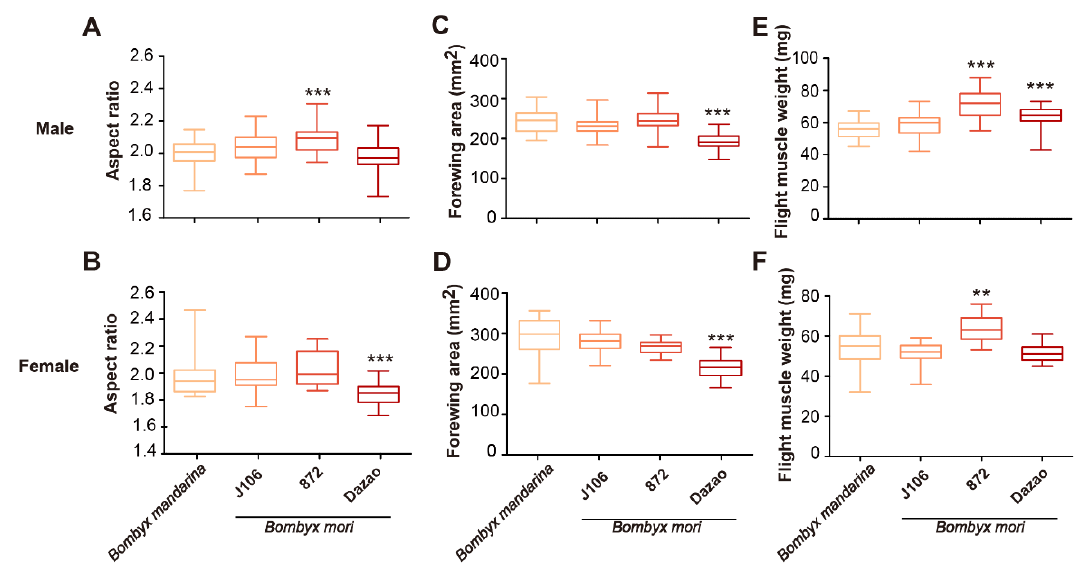
Figure 3. Wing shape (aspect ratio), forewing area (mm 2 ) and flight muscle weight (mg) of silkmoths. The box-plot and box color are described in the legend of Figure 2. The X -axis of the above figures were the same as the bottom. We applied ANOVA tests between B. mandarina and J106, 872, Dazao, respectively. Tukey HSD post hoc tests were shown in Table 3. The significance level is 0.05 (* p < 0.05, ** p < 0.01, *** p < 0.001). ( A ) The wing shape (aspect ratio) of B. mori was similar to that of B. mandarina in males except for 872. ( B ) In females, the wing shape (aspect ratio) of B. mori were similar to that of B. mandarina except for Dazao. The forewing areas (mm 2 ) were similar in males ( C ) and females ( D ) except for Dazao. ( E ) In males, the weight of flight muscles was similar in B. mandarina and domestic J106, but the domestic 872 and Dazao had a larger flight muscle weight than B. mandarina . ( F ) In females, the flight muscle weight (mg) of B. mandarina was similar to J106 and Dazao, and the B. mori 872 had heavier flight muscles than B. mandarina . Table 2. Multi-way ANOVA tests of measurements of flight apparatus. The table shows the effects of sex, population and their interaction (population × sex) on morphological measurements. The significance level is 0.05 (Tukey HSD post hoc tests).